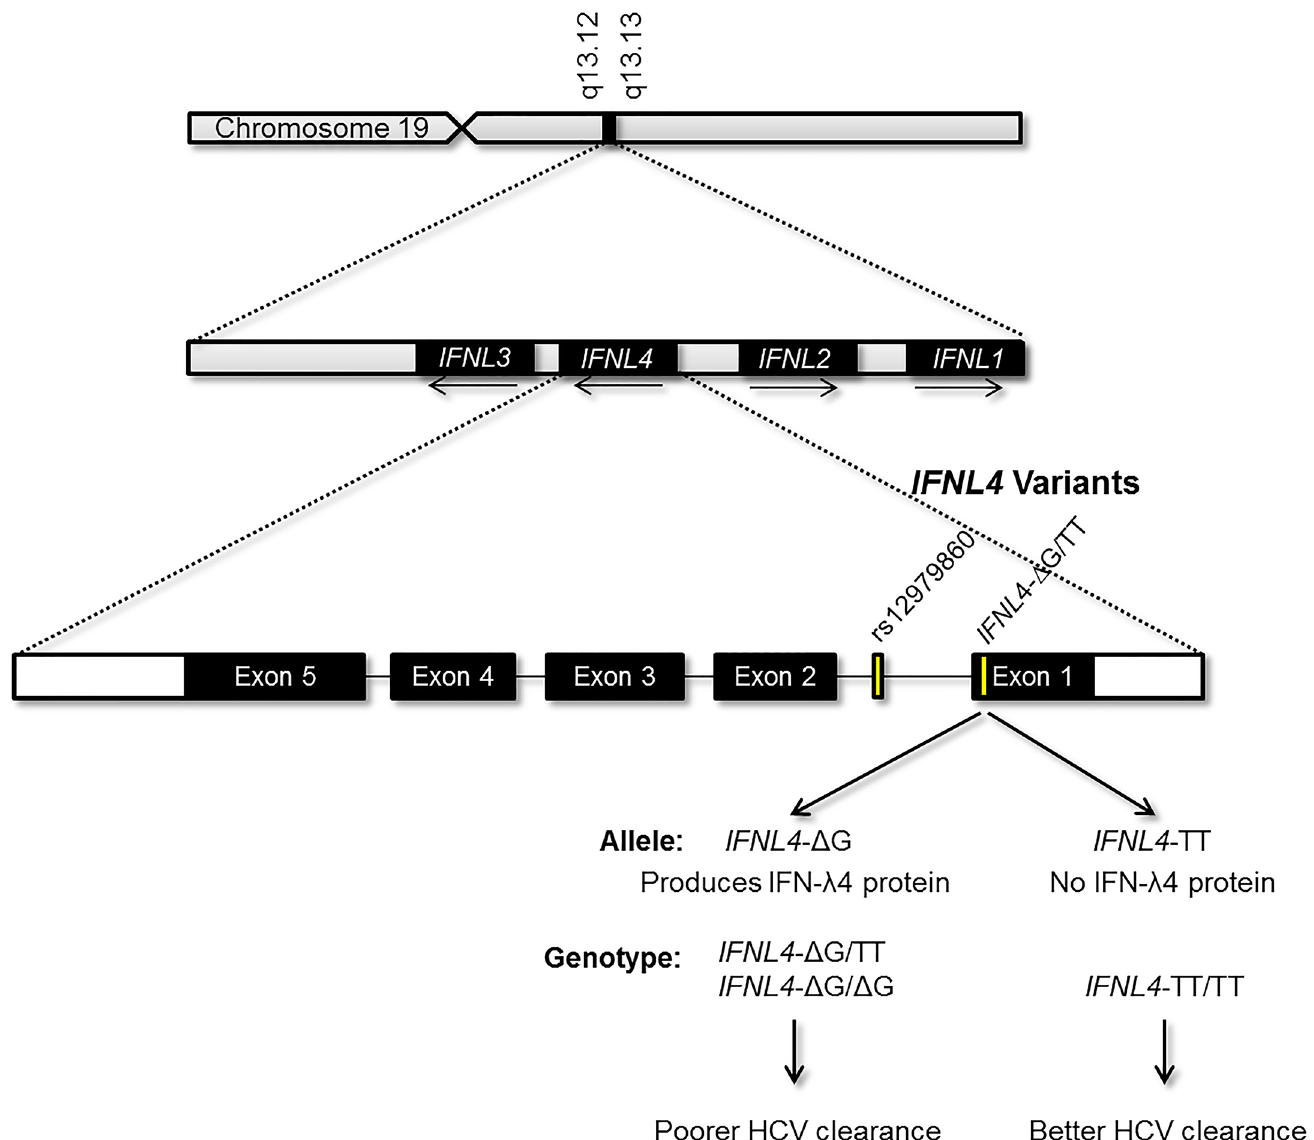
Fig 1. Depiction of IFNL4 within the interferon lambda region on chromosome 19, as well as the exonic structure of the gene and the location of the rs12979860 and IFNL4 - Δ G/TT genetic variants. Only carriers of the IFNL4 - Δ G allele, which has been associated with poorer clearance of HCV infection, are able to produce the IFN- λ 4